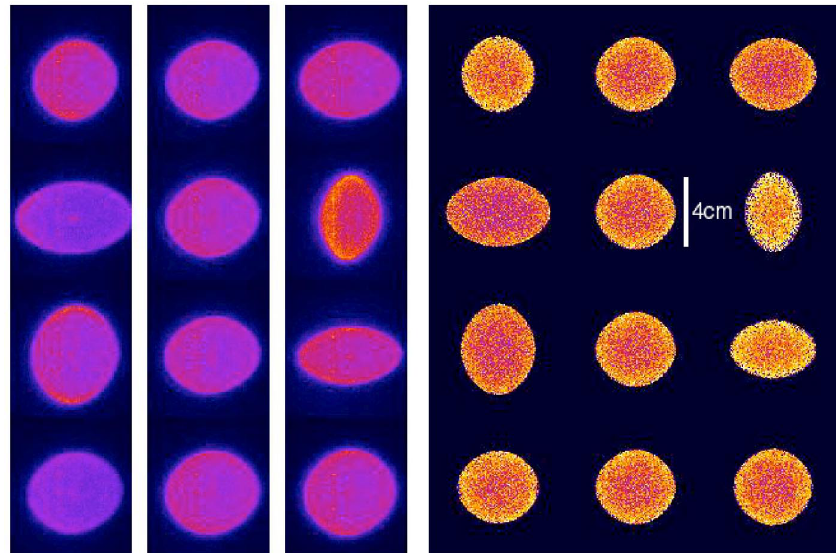
FIG. 37. (Color) Numerical results (right panel) and camera images (left panel) of NTX beam profiles as a function of the quadrupole field